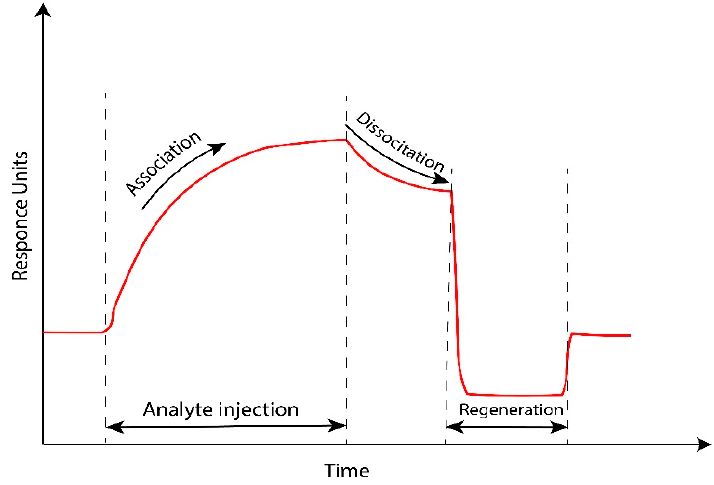
Figure 4. Surface plasmon resonance (SPR) sensogram.